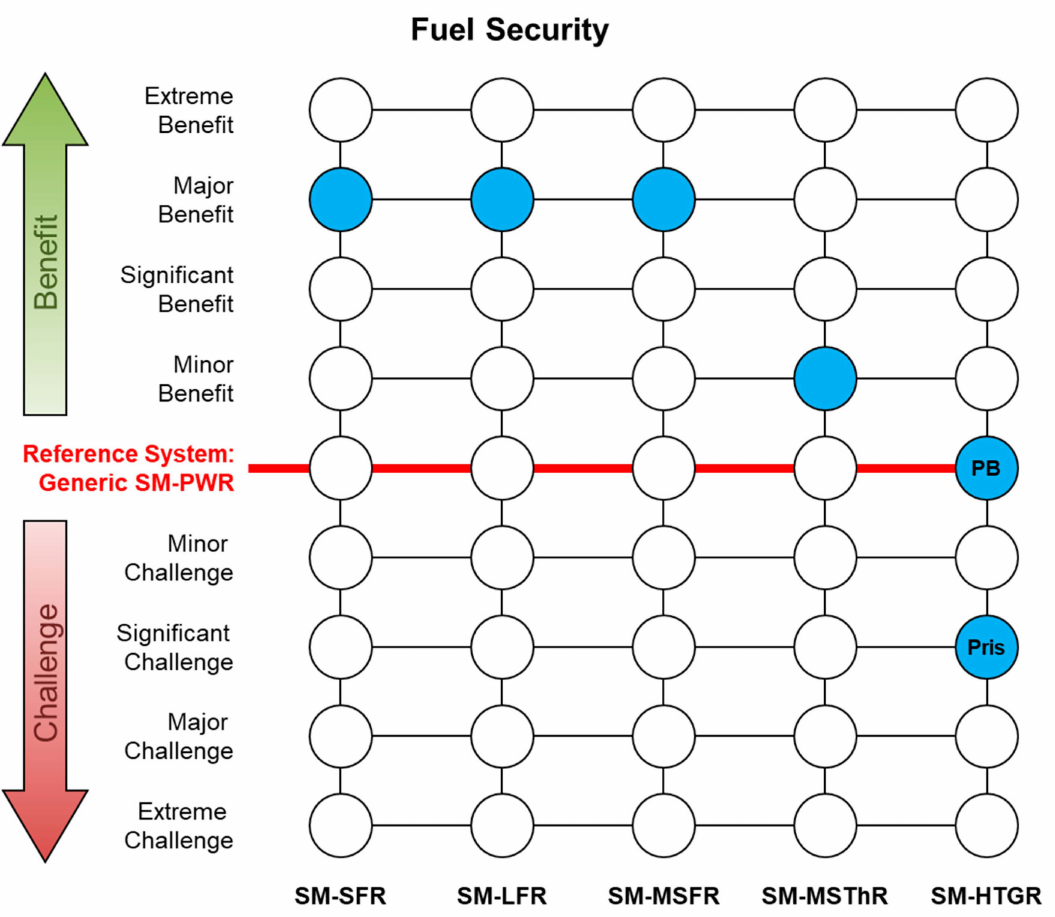
Figure 8. Fuel Security from GFAs. SM-HTGR has two ratings in this example, depending on whether a Pebble Bed (PB) or Prismatic block core is